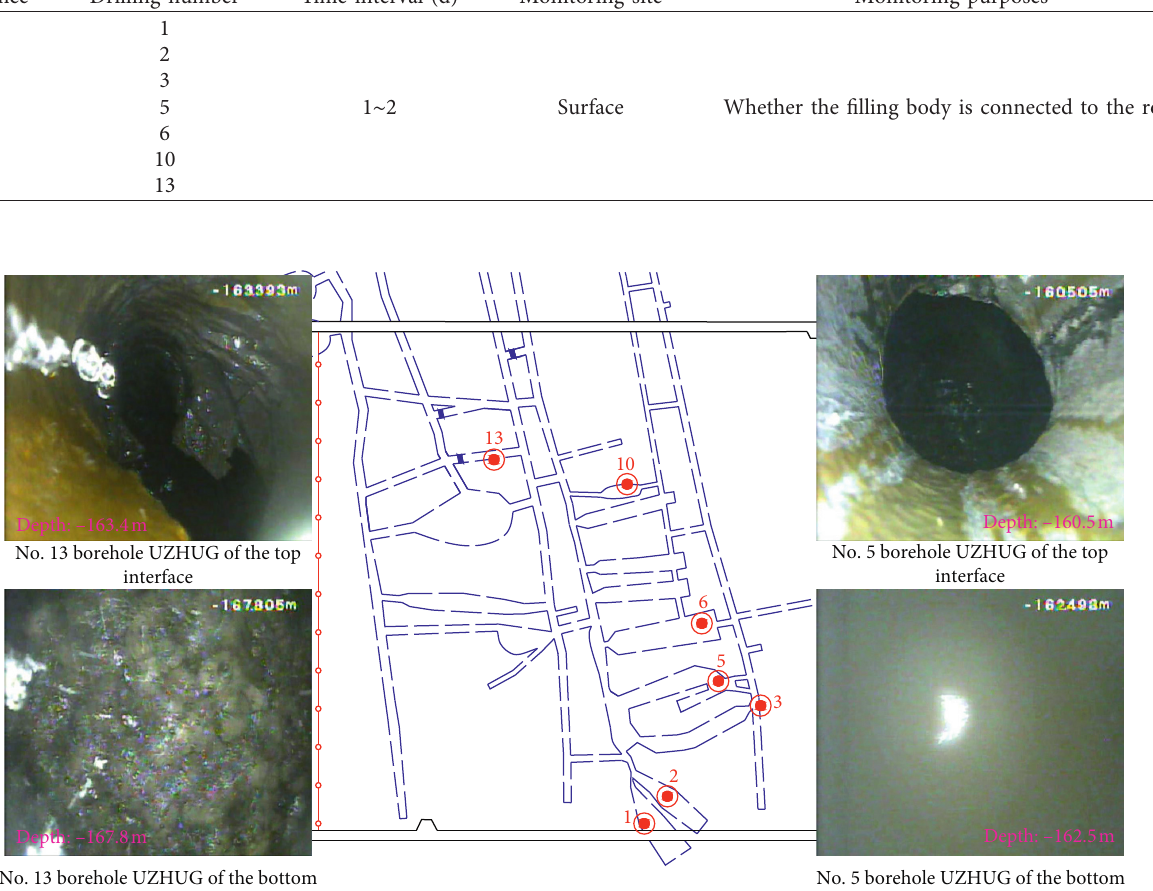
Figure 12: Borehole layout and observation results from